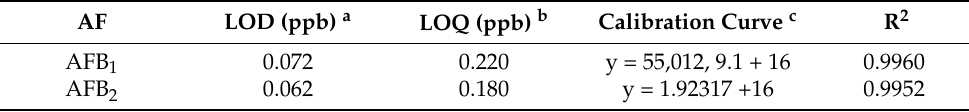
Table 1. Validation of the quantification of AFs by